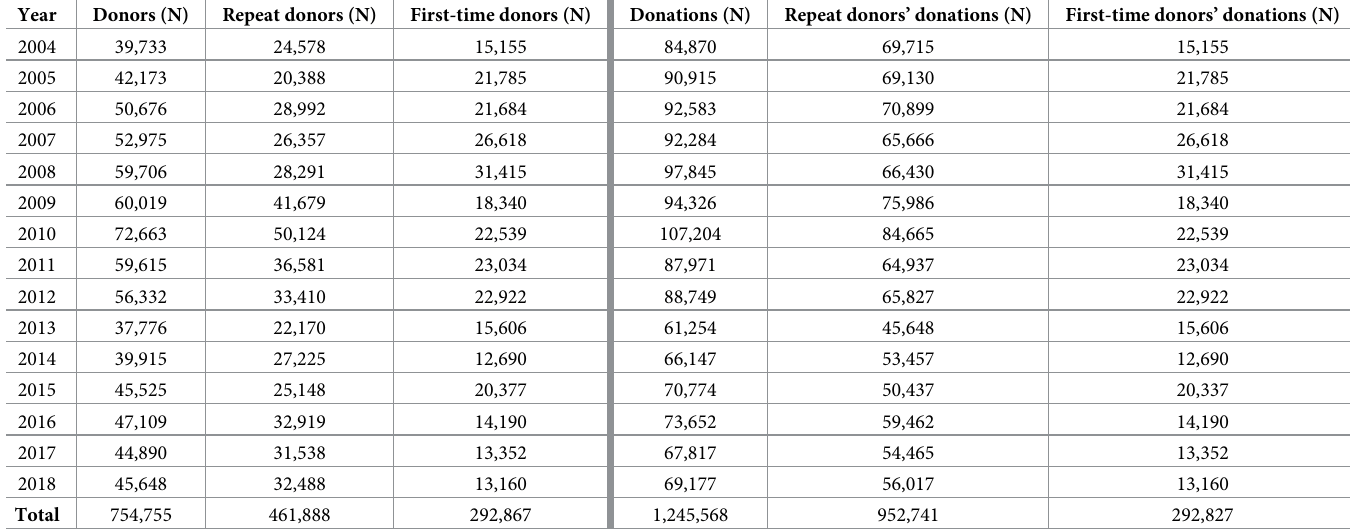
Table 2. Number of blood donors and donations in the Lithuanian National Blood Center.